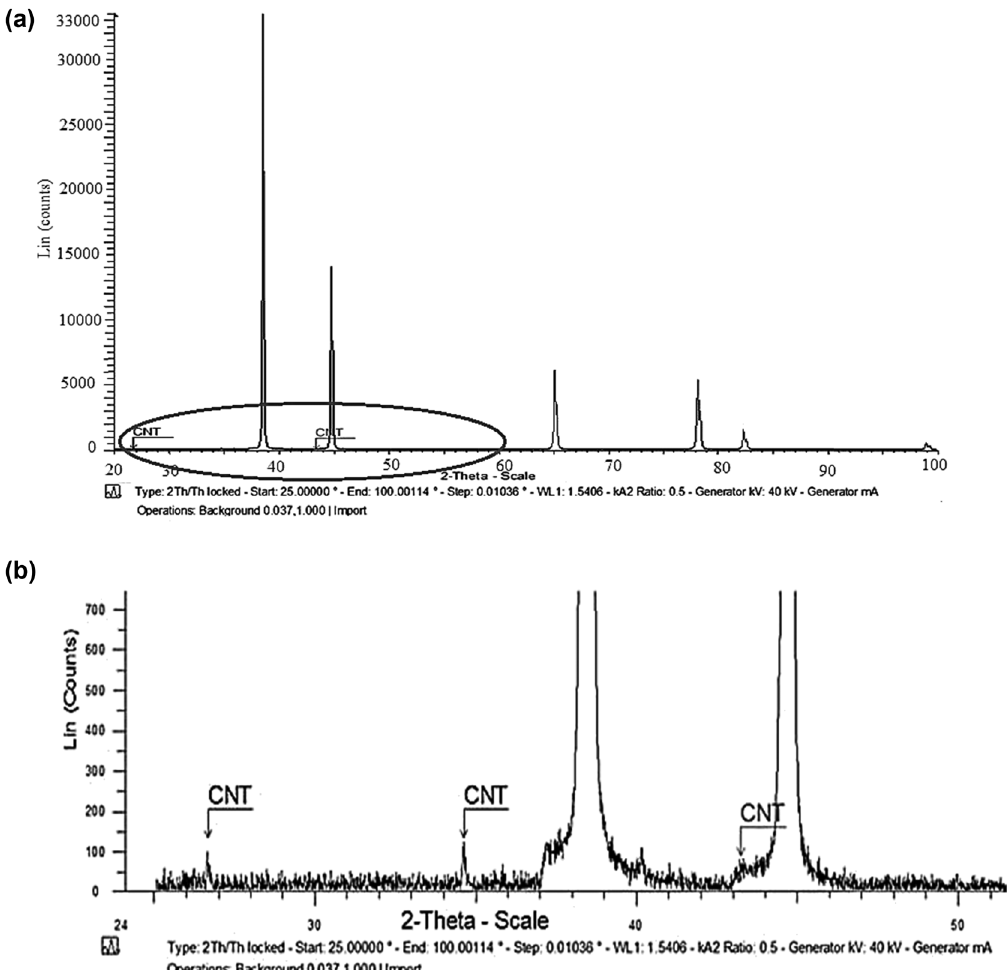
Figure 12: ( a ) XRD image of Al – Cu – Mg – T351 + 0.5% MWCNT composite. ( b ) Enlarged XRD image of Al – Cu – Mg – T351 + 0.5% MWCNT